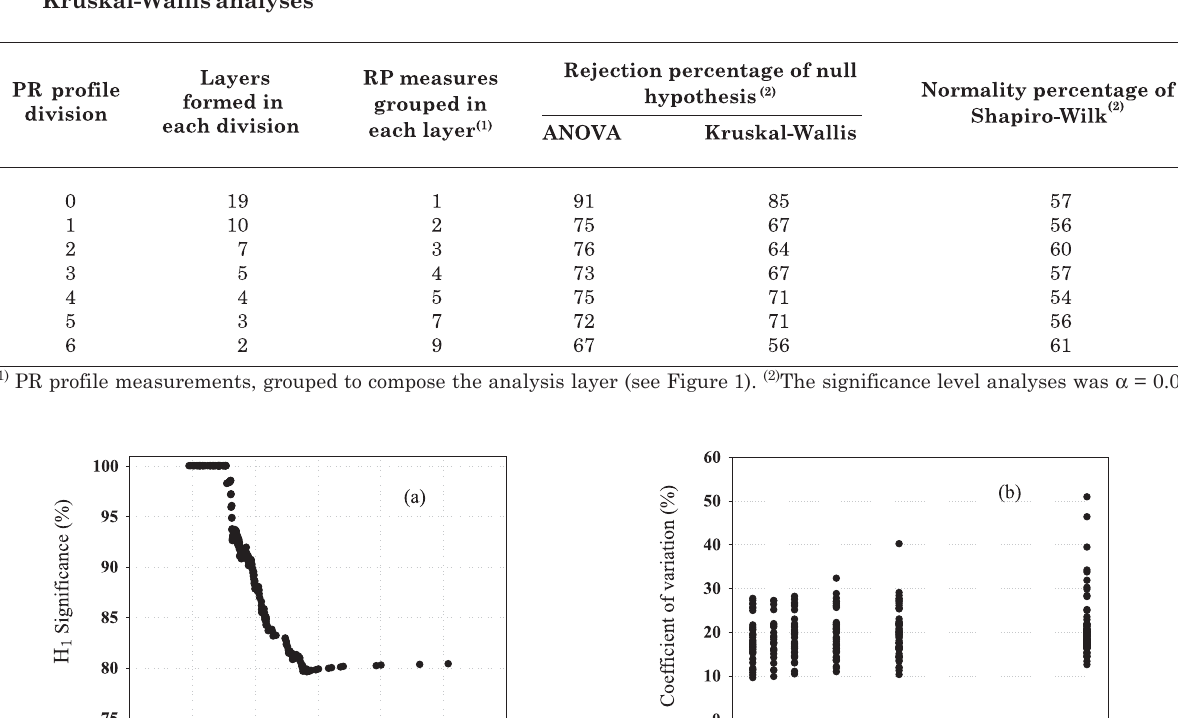
(b).Table 1. Discrimination of the effects of compaction levels on penetration resistance (PR) by ANOVA and Kruskal-Wallis